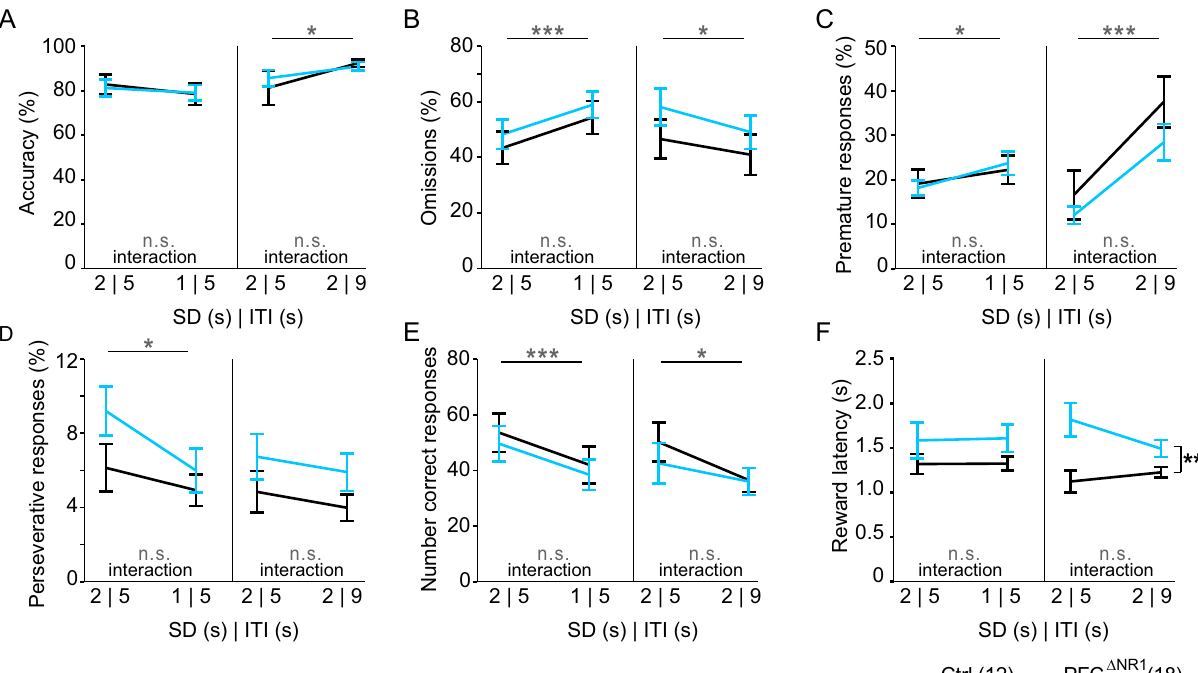
Figure 4. 5-choice-serial-reaction-time task (5-CSRTT) performance. Results of attention challenge (reduction of stimulus duration, SD, from 2 to 1 s; left) and impulsivity challenge (increase of inter-trial-interval, ITI, from 5 to 9 s; right) across six key parameters of the 5-CSRTT. ( A ) Accuracy as primary measure of attention, ( B ) relative omissions as a measure of task engagement and attentiveness, ( C ) relative premature responses as primary measure of waiting impulsivity, ( D ) relative perseverative responses, ( E ) total number of correct responses (earned rewards), and ( F ) latency to collect the reward as a compound proxy for locomotor drive and motivation. Grey statistical indicators relate to RM-ANOVA, with asterisks on horizontal lines indicating effect of challenge, and asterisks on vertical lines referring to an effect of group; no significant challenge-group interactions were found. The legend indicates the colour-code and size of each group. See Supplementary Table 4 for all related statistics. n.s., P > 0.1, * P < 0.05, ** P < 0.01 *** P < 0.001. Error bars,